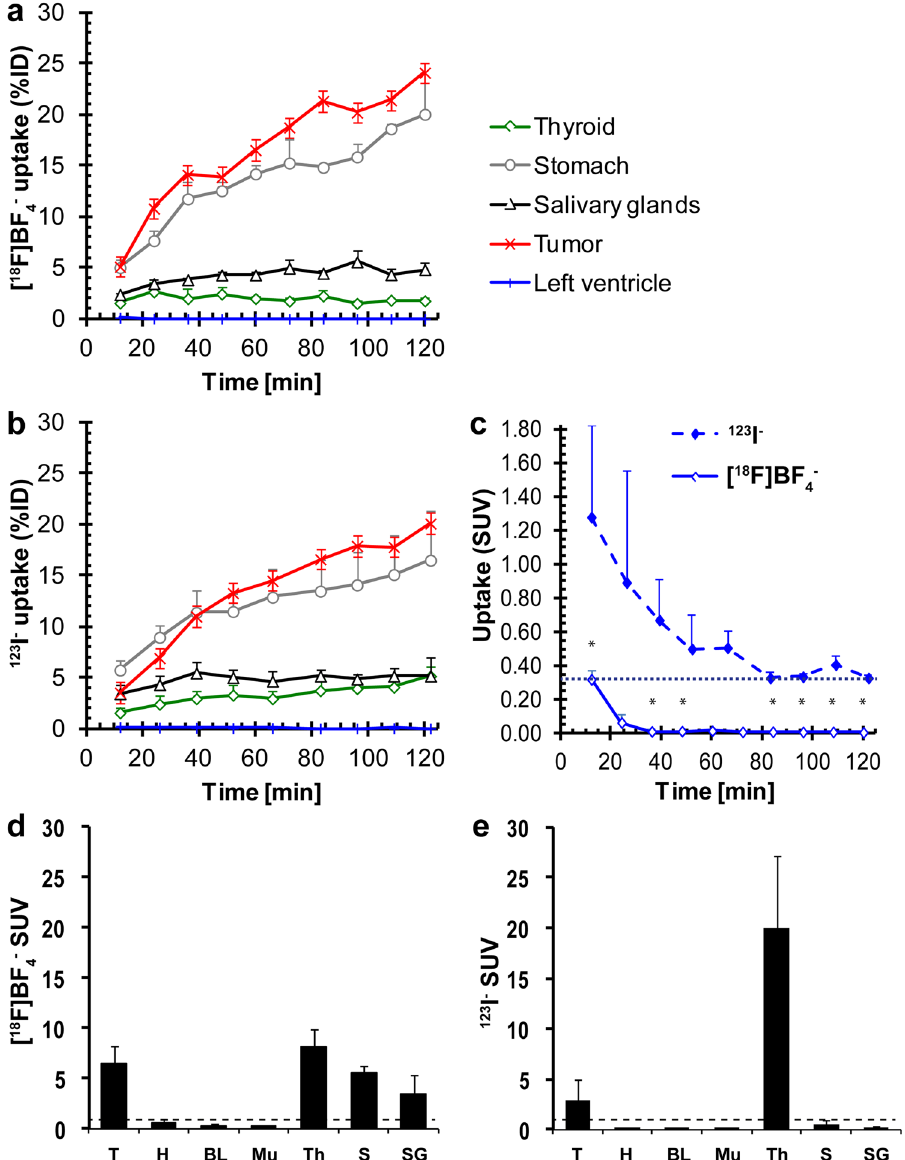
Figure 4. Quantitative analysis of in vivo NIS imaging and ex vivo biodistribution data reveals differences in pharmacokinetics between the PET tracer [ 18 F]BF 4 − and the SPECT tracer [ 123 I]iodide. ( a/b ) Image data analysis of ( a ) dynamic [ 18 F]BF 4 − -PET and ( b ) sequential [ 123 I]iodide-SPECT experiments was performed as described in Materials and Methods. Cumulative data of organs expressing exogenous human NIS (primary tumor, red) and expressing endogenous NIS (thyroid, green; salivary glands, black; stomach, grey) are shown for each tracer. A heart volume comprising of the left ventricle was used as a surrogate for the blood pool (blue). Tracer batches were identical for all animals and experiments performed on the same day (N = 3 animals for each tracer). ( c ) A more detailed view of the radioactivity time course in the left ventricle (surrogate for the blood pool in vivo ). It demonstrates the faster and more complete clearance of [ 18 F]BF 4 − as compared to [ 123 I] iodide. ( d/e ) Ex vivo radioactivity analysis by γ -counting of harvested tissues was performed subsequent to imaging. Cumulative SUV data of all experimental animals of the [ 18 F]BF 4 − ( d ) and [ 123 I]iodide ( e ) cohorts (N = 5 each). Abbreviations are (from left to right): primary tumors (T), heart (H), blood (BL), muscle (Mu), thyroid (Th), stomach (S), and salivary glands (SG). Error bars in all panels represent